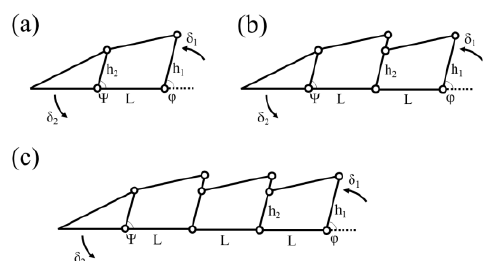
Figure 6. Schematic illustrations of a gripper finger structure consisting of ( a ) one, ( b ) two, and ( c ) three four-bar linkages, respectively.